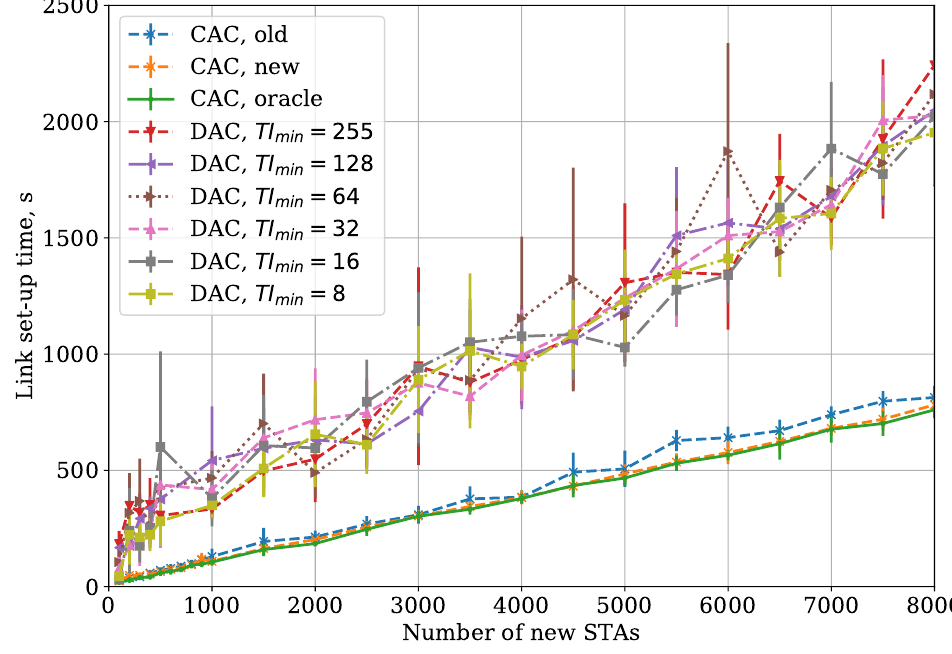
Figure 9. CAC and DAC protocols: dependency of the link set-up time on the number of new STAs for the Large Area case with Capture